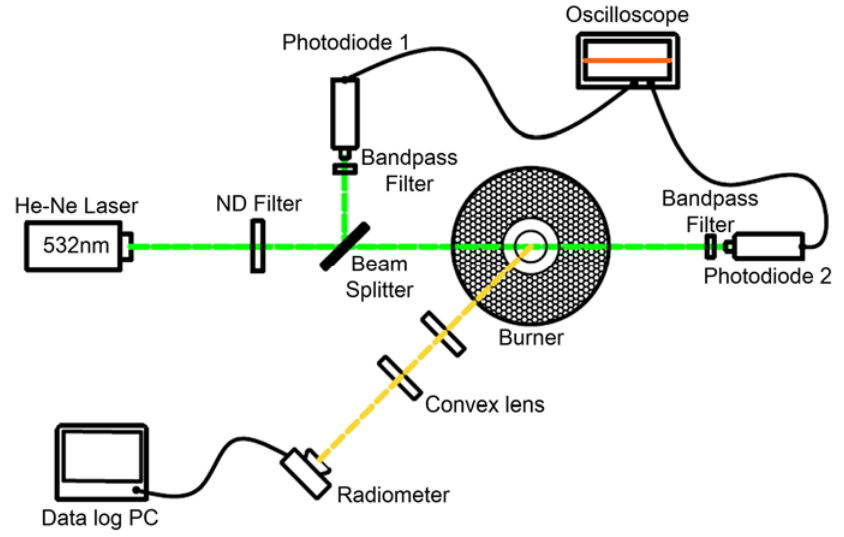
Figure 2. Schematic of laser extinction measurement and radiometer device.